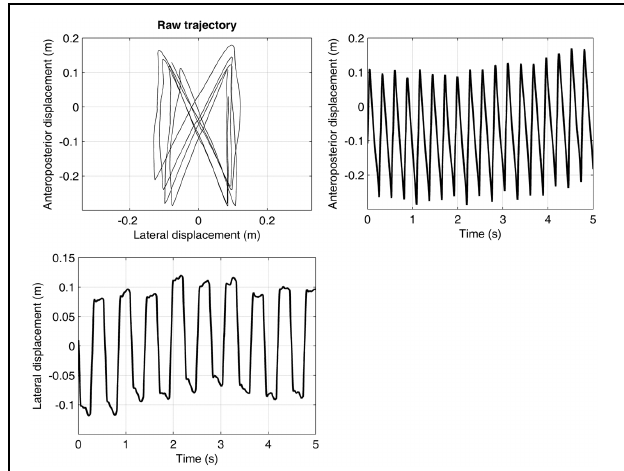
FIGURE 1 | Trajectory of the center of pressure. A participant walked at preferred walking speed (1.25m · s − 1 ) during 5min. on an instrumented treadmill, which measured the feet pressure on the treadmill belt. The trajectory of the center of pressure was computed (barycenter method). Only 5s are shown. The upper-left panel shows the raw trajectory. The upper-right and lower panels show the decomposition of the raw trajectory in, respectively, the anteroposterior and the mediolateral